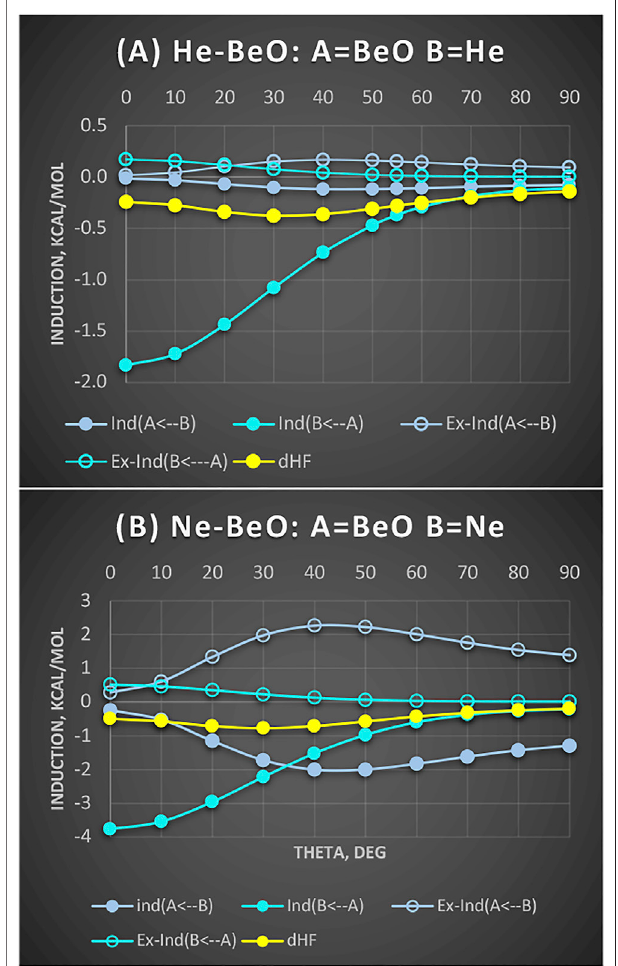
FIGURE 4 | He-BeO (A) and Ne-BeO (B) at R = 3.0 Å: Partitioning of induction terms into mutual contributions of A = BeO and B=He/Ne. Solid circles are induction terms and open circles are exchange-induction terms. Values in